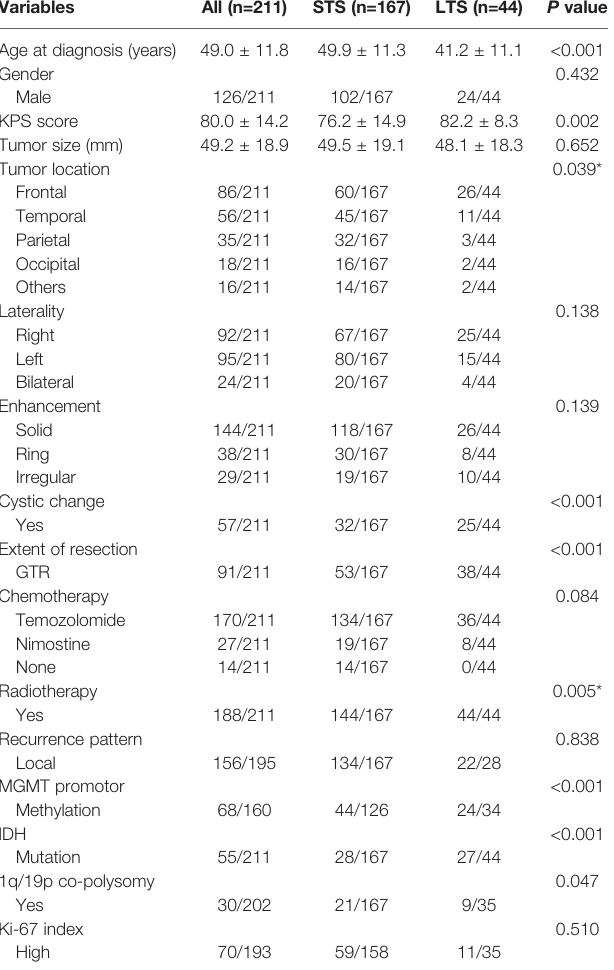
KPS, Karnofsky performance scale; GTR, gross-total resection; MGMT, O 6 - methylguanine-DNA-methyltransferase; IDH, isocitrate dehydrogenase. *by Fisher exact test.